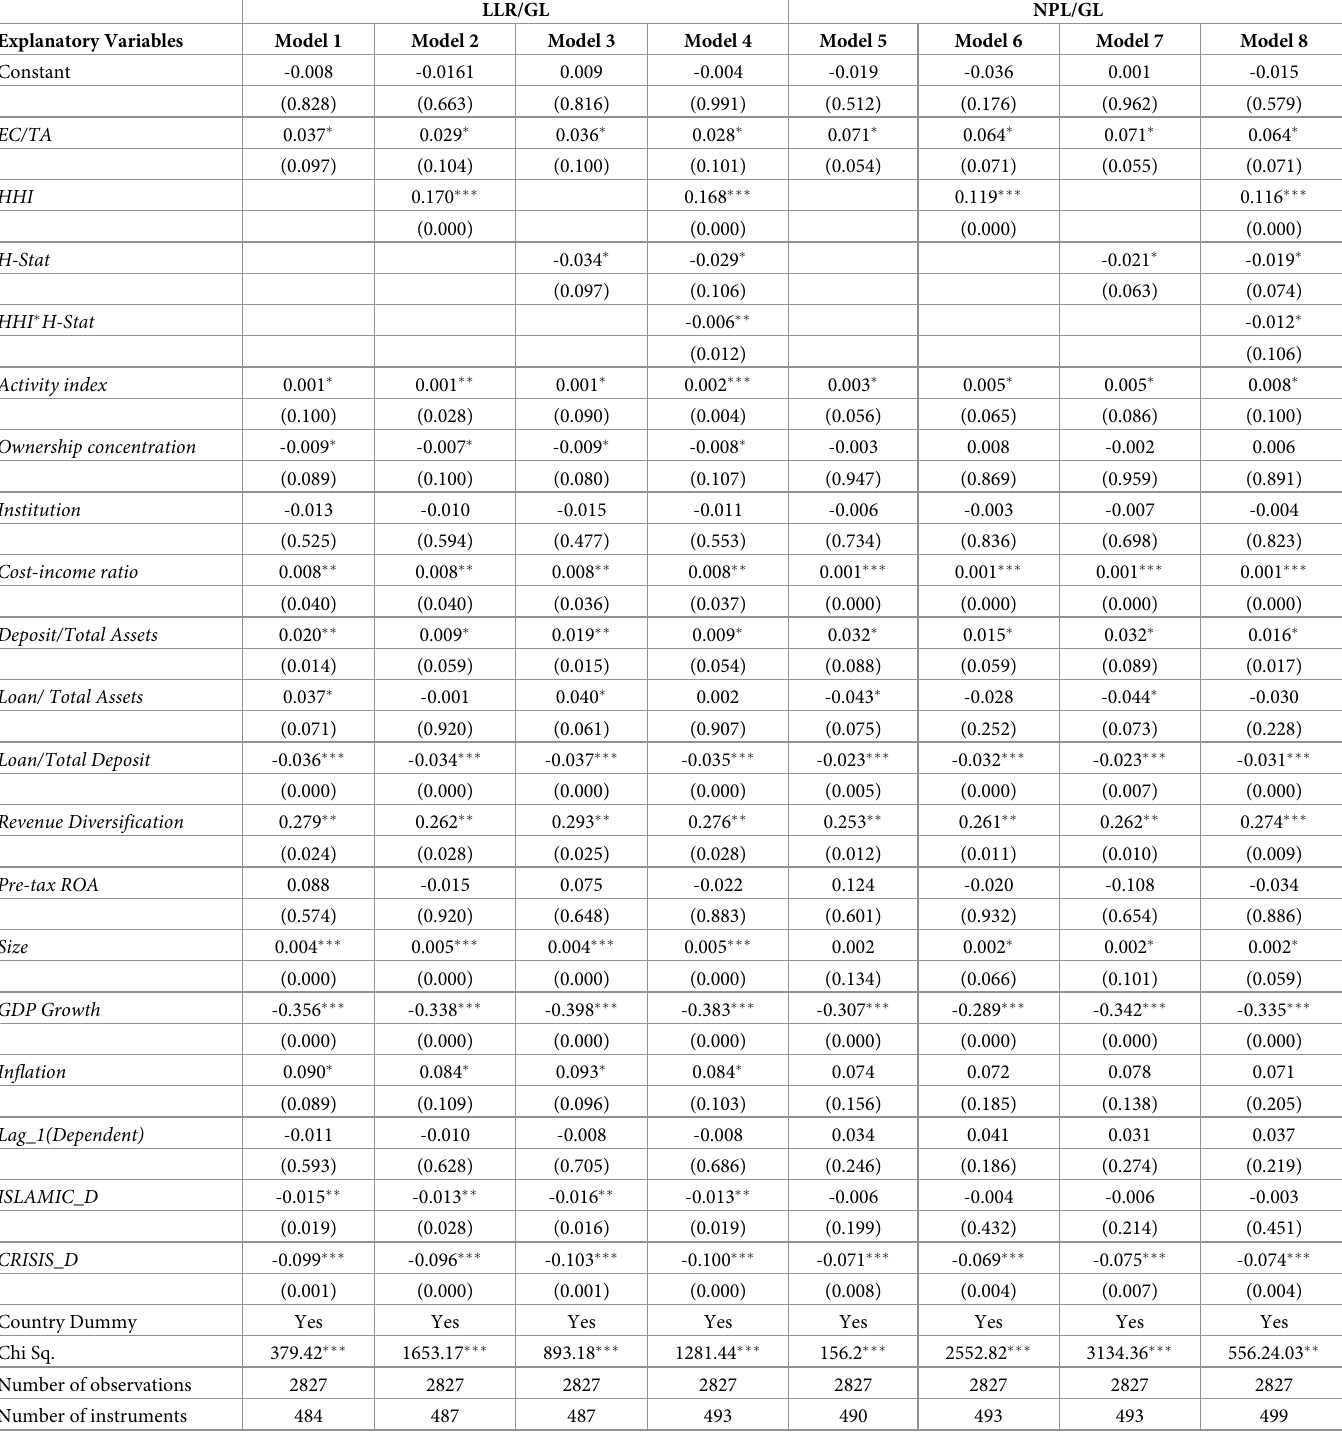
Table 10. Panel regressions (GMM) of competition and credit risk (all banks,